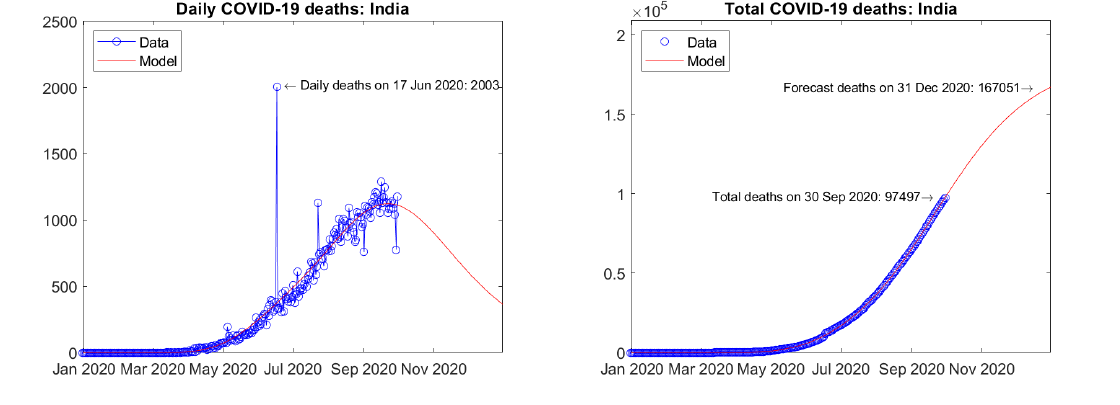
Figure 5. Actual and predicted trends in India: ( a ) daily deaths, ( b ) total